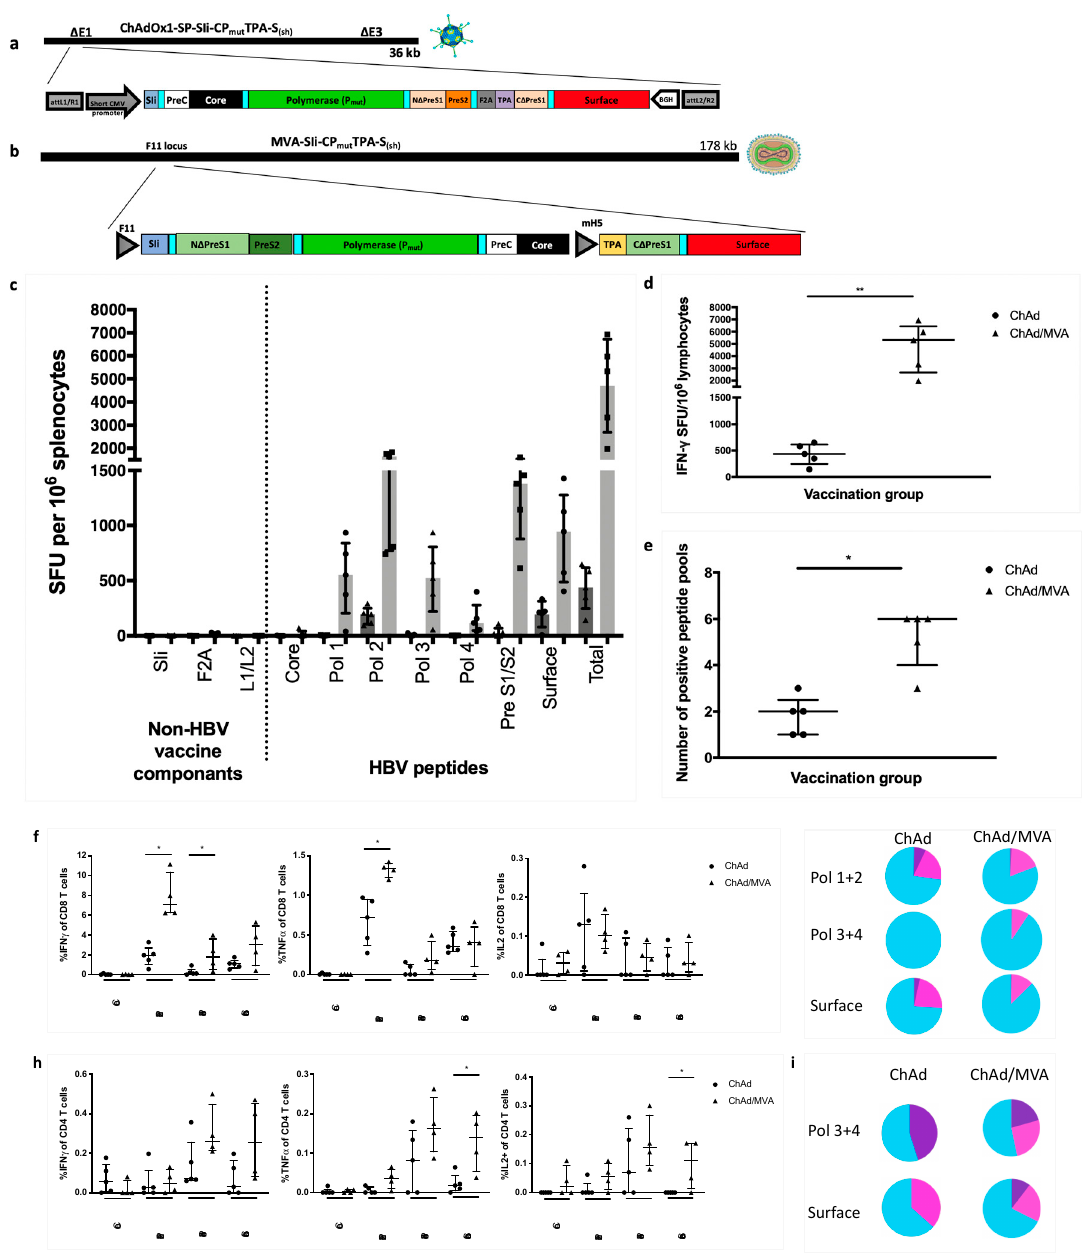
Figure 6. Priming with ChAdOx1-SP-SIi-CP mut TPA-S (sh) and boosting with MVA-SIi-CP mut TPA-S (sh) enhances the magnitude of vaccine induced T cell responses. C57BL/6J mice were vaccinated intramuscularly with 5 × 10 7 IU of ChAdOx1-SP-SIi-CP mut TPA-S (sh) alone (ChAd, n = 5, construct shown in ( a )) or followed 7–8 weeks later by 2 × 10 6 plaque forming units of MVA-SIi-CP mut TPA-S (sh) (MVA, n = 5, construct shown in ( b )). Splenocytes extracted 14 days after vaccination and plated in IFN γ ELISpot assays with pools of overlapping peptides corresponding to the vaccine immunogen ( c ). T cell response magnitude was measured by the number of IFN γ SFU per million lymphocytes ( d ) and breath was measured by the number of positive peptide pools ( e ) (over 100 IFN γ SFU/million cells defined as positive). Splenocytes extracted 14 days after vaccination were plated with pools of overlapping peptides corresponding to the vaccine immunogen and stained intracellularly for detection of cytokine production, shown as percentage of CD8+ cells producing IFN γ (left panel), TNF α (middle panel) or IL-2 (right panel) ( f ), proportion of CD8+ T cells that are single (blue), double (pink) or triple (purple) cytokine producers ( g ) percentage of CD4+ cells producing IFN γ (left panel), TNF α (middle panel) or IL-2 (right panel) ( h ) and proportion of CD4+ T cells that are single (blue), double (pink) or triple (purple) cytokine producers ( i ). Median and interquartile ranges are shown.